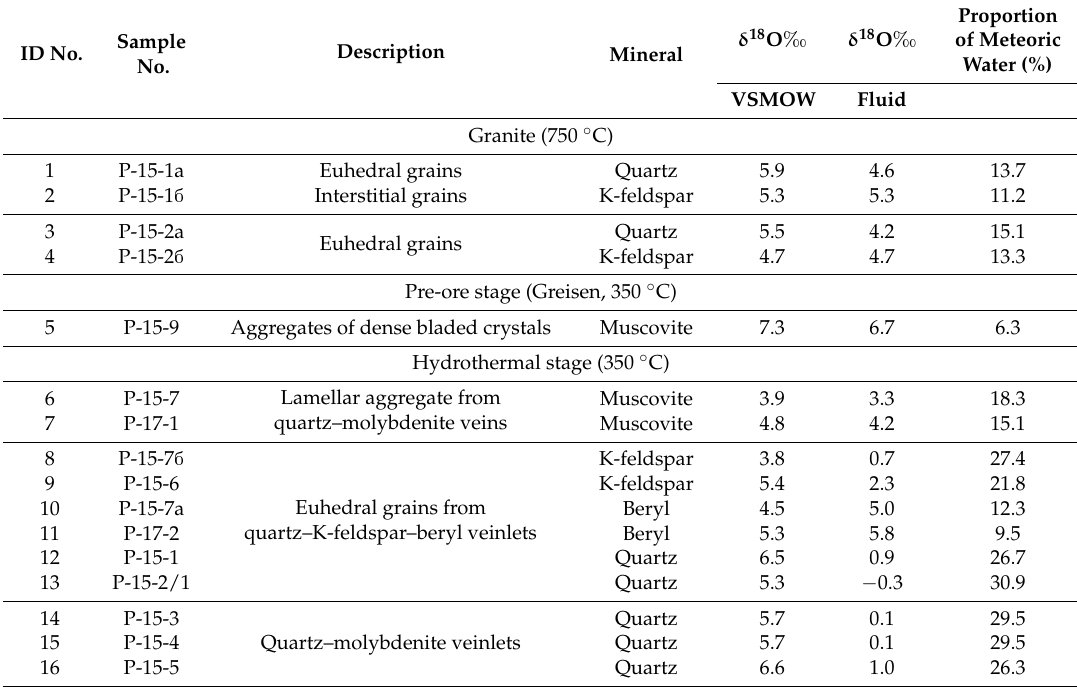
Table 1. The δ 18 O values in minerals from the Pervomaika